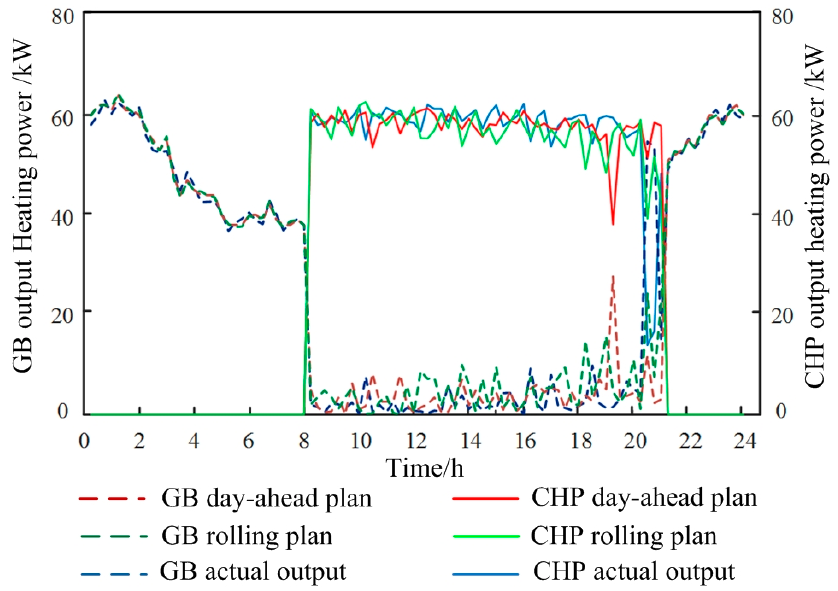
Figure 8. Comparison of day-ahead plan, rolling plan and actual output of thermal power output of gas-fired boilers and CHP.